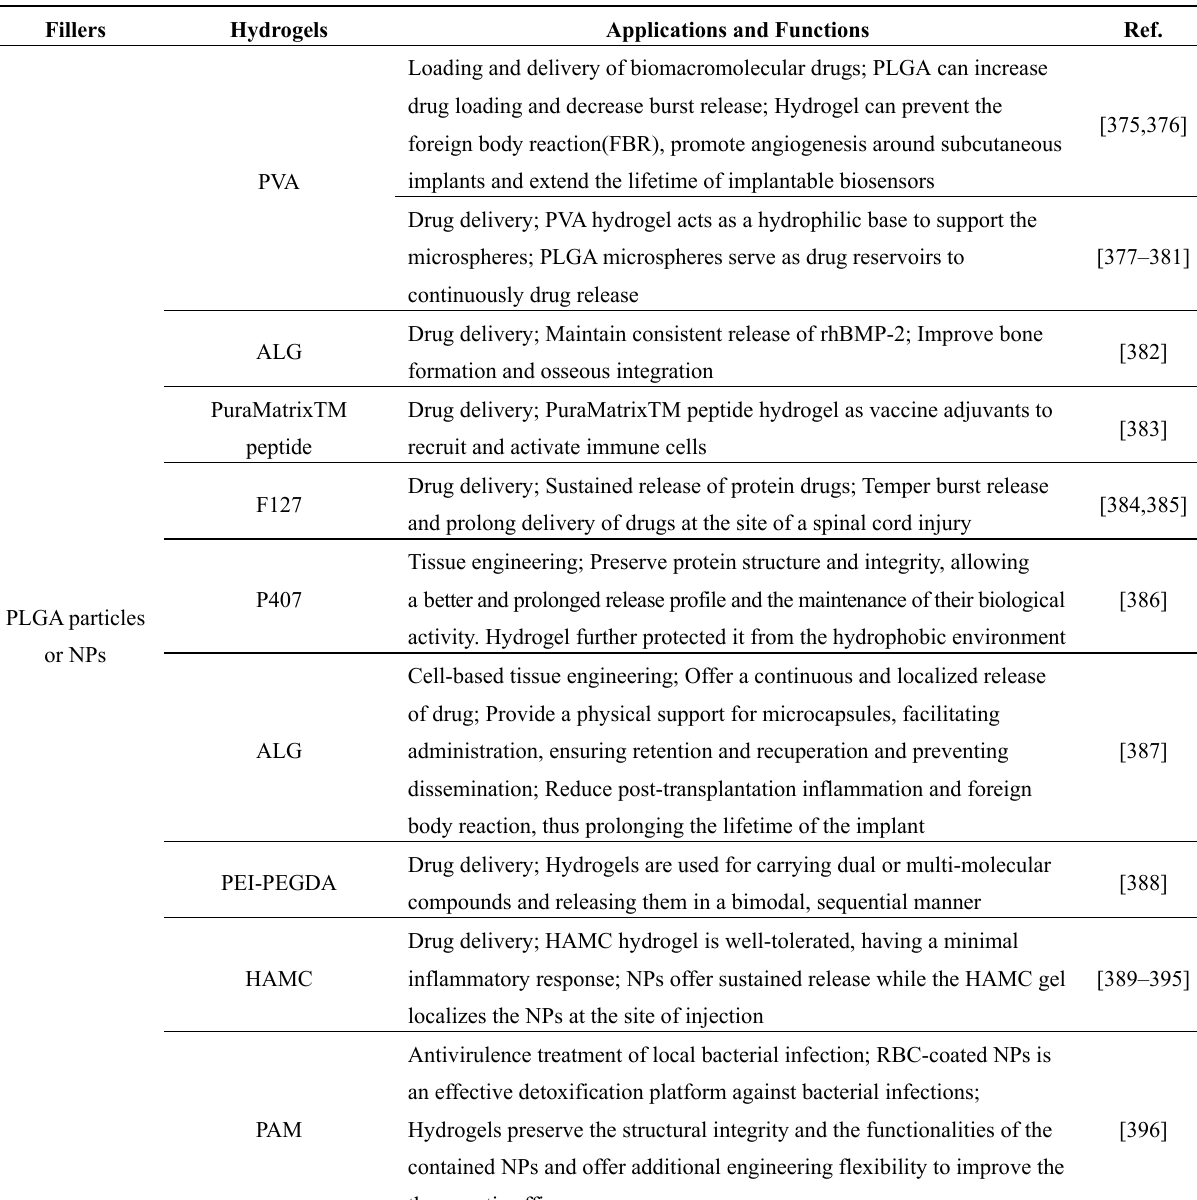
Table 4. Summary of nanocomposite hydrogels from hydrogels and polymeric NPs or liposomes for biomedical